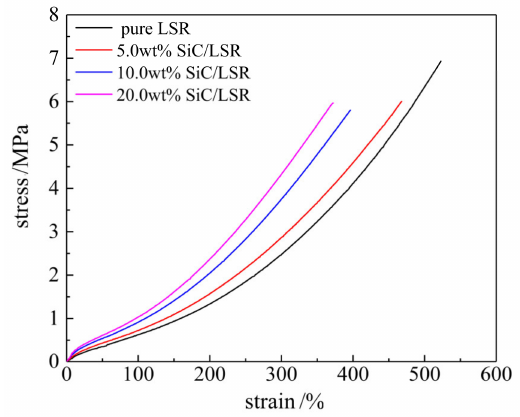
Figure 4. Stress–strain characteristics of SiC/LSR